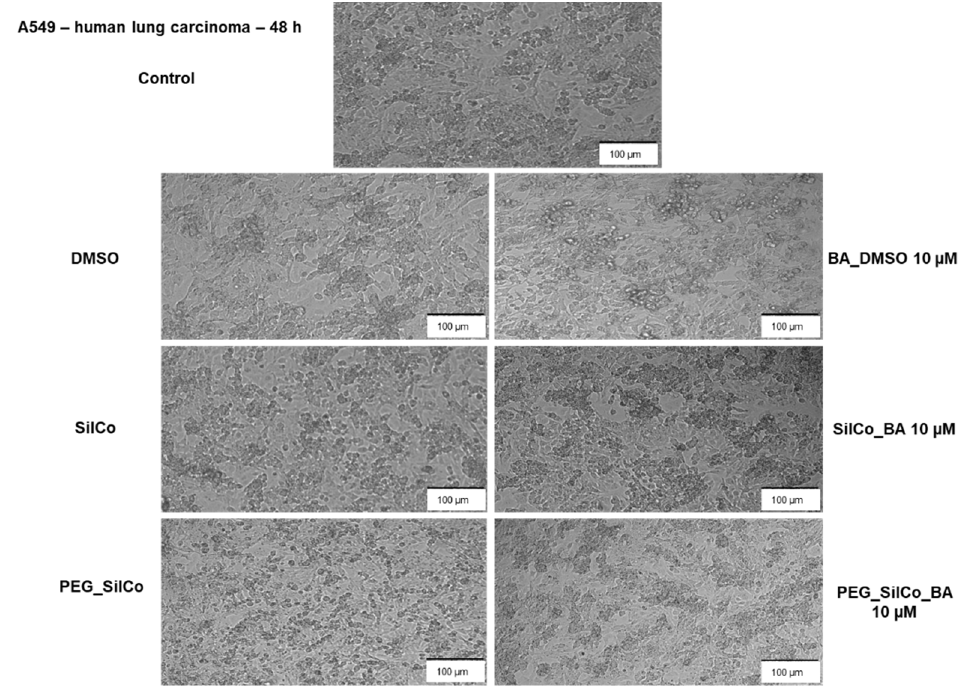
Figure 7. Microscopical appearance of A549 cells after a 48-h treatment with 10 µM of test compounds (BA_DMSO, SilCo_BA, PEG_SilCo_BA, SilCo, PEG_SilCo and DMSO). The pictures were taken at 48 h post-treatment under bright field light. Scale bar represents 100 µm.